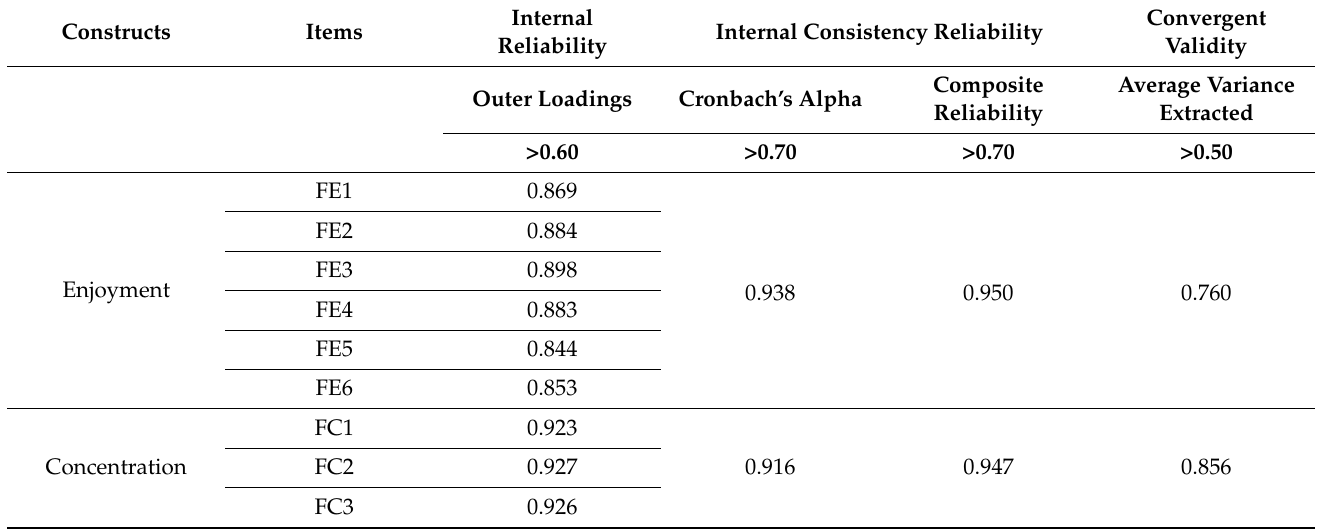
Table 4. Results Summary for Reflective Measurement